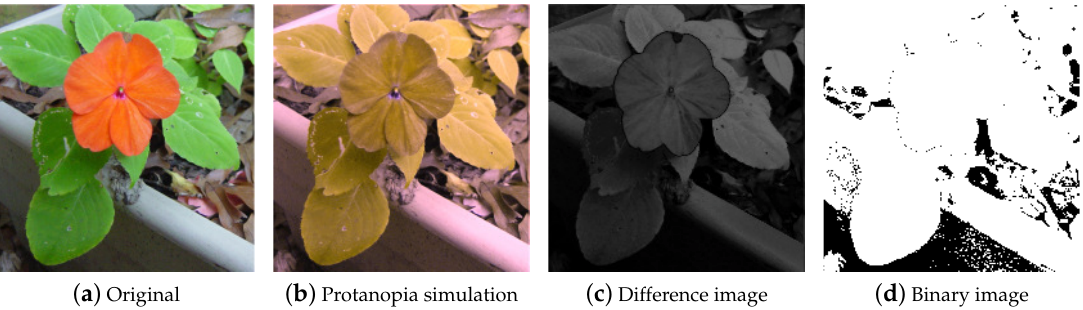
Figure 6. An example of Protanopia simulation. ( a ) is the original image and ( b ) is the Protanopia simulation result. ( c ) is the difference of ( a , b ) computed in the λ , Y-B , R-G color space. ( d ) is the binarized version of ( c ) for better